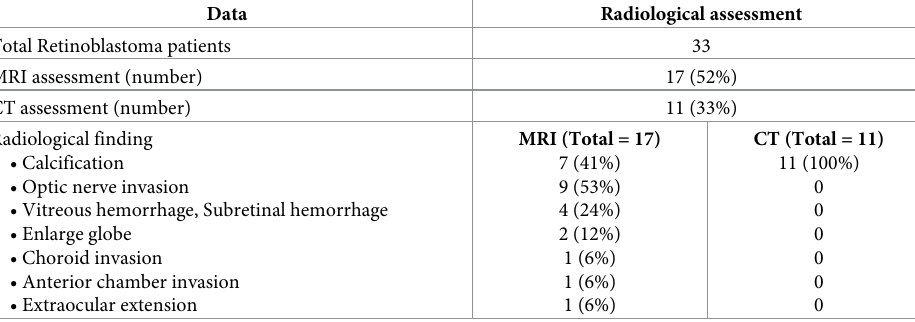
Table 3. Radiological modality assessment in retinoblastoma patients.